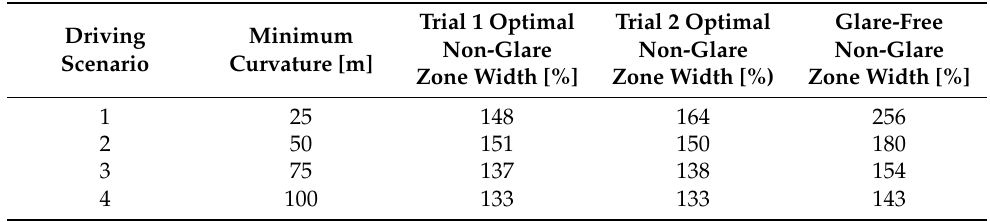
Table 6. Best non-glare zone width vs. minimum curvature of the S-curve in all four driving scenario simulations.